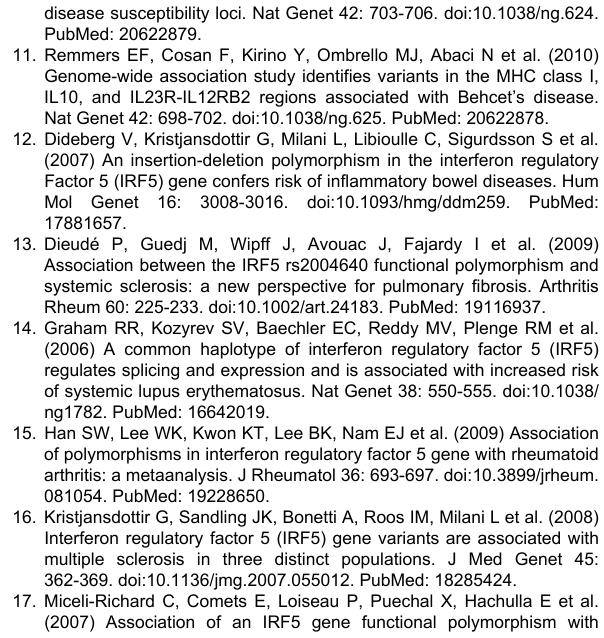
Figure S1. Linkage disequilibrium between the analyzed IRF5 genetic variants.